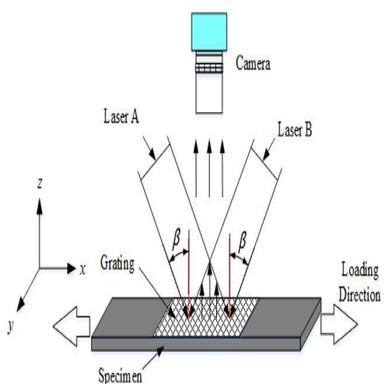
Schematic diagram of moiré interference of two beam.